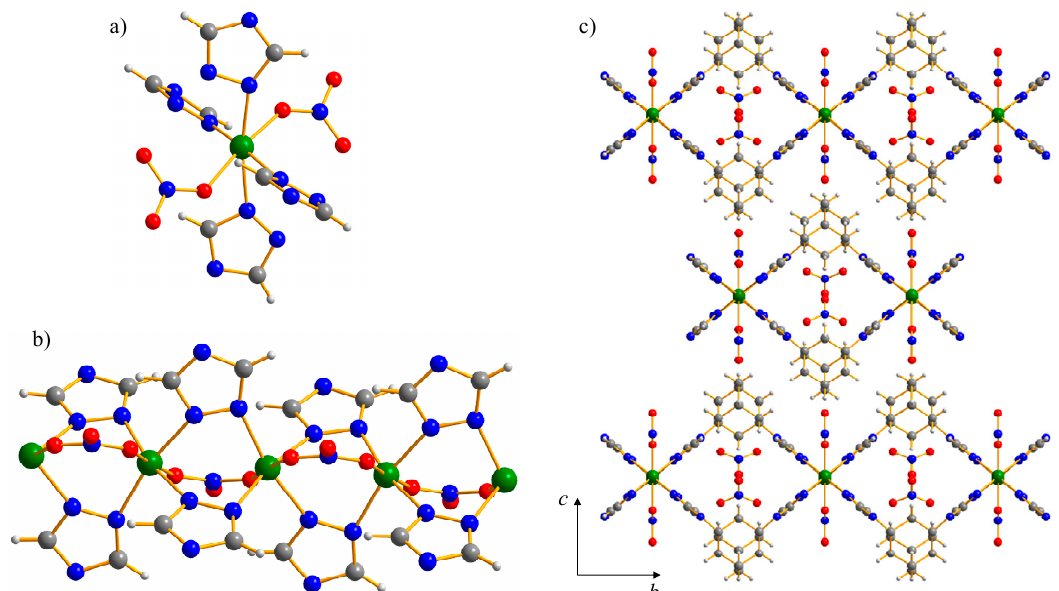
Figure 7. Representation of the crystal structure of {[Cu(tr 2 ad)(NO 3 )](NO 3 )} n : ( a ) the coordination sphere of the metal ions; ( b ) portion of the 1-D polymeric chain; ( c ) portion of the packing, viewed along the [100] crystallographic direction. Horizontal axis, b ; vertical axis, c . Atoms colour code: C, grey; H, light grey; Cu, green; N, blue; O, red. Main bond distances (Å) and angles ( ◦ ) at the metal ions: Cu–N 2.03(1), 2.148(9); Cu–O 2.09(2), 2.26(2); intra-chain shortest Cu ··· Cu 3.54(2); inter-chain shortest Cu ··· Cu 10.7226(7); N–Cu–N 76.4(6), 97.01(3), 173.5(5); O–Cu–O 180(1); O–Cu–N 68.9(5), 70.3(6), 109.8(6), 111.0(6).